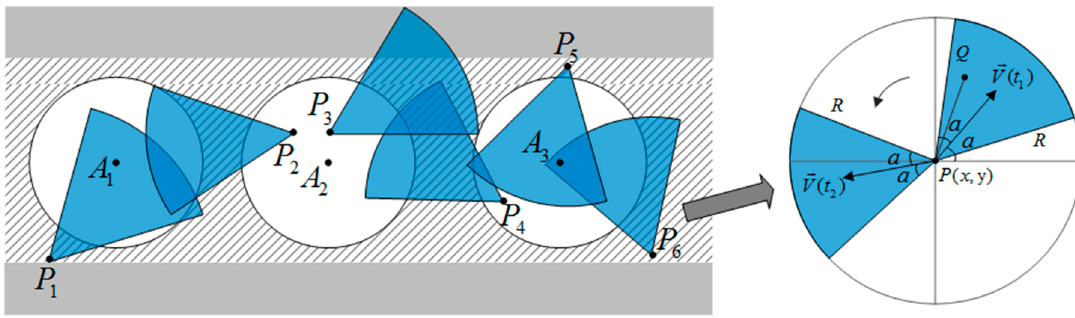
Figure 5. Effective coverage issue for WMSNs of coalmine and the directional adjustable sensing